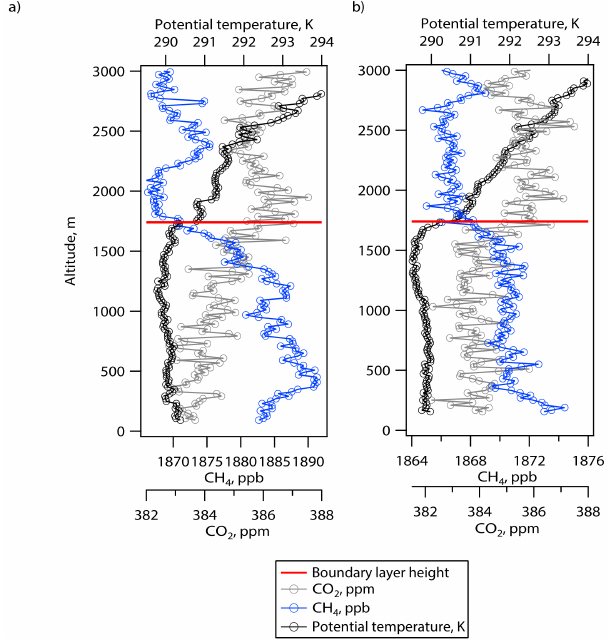
Figure 3. (a) Ascending (01:00GMT) and (b) descending (15:00GMT) potential temperature profiles performed over So- dankylä during flight B720, used to determine the boundary layer height as described in the